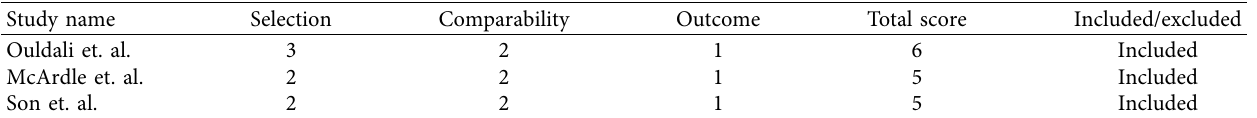
Mean scores greater than or equal to 5 are included in the analysis.